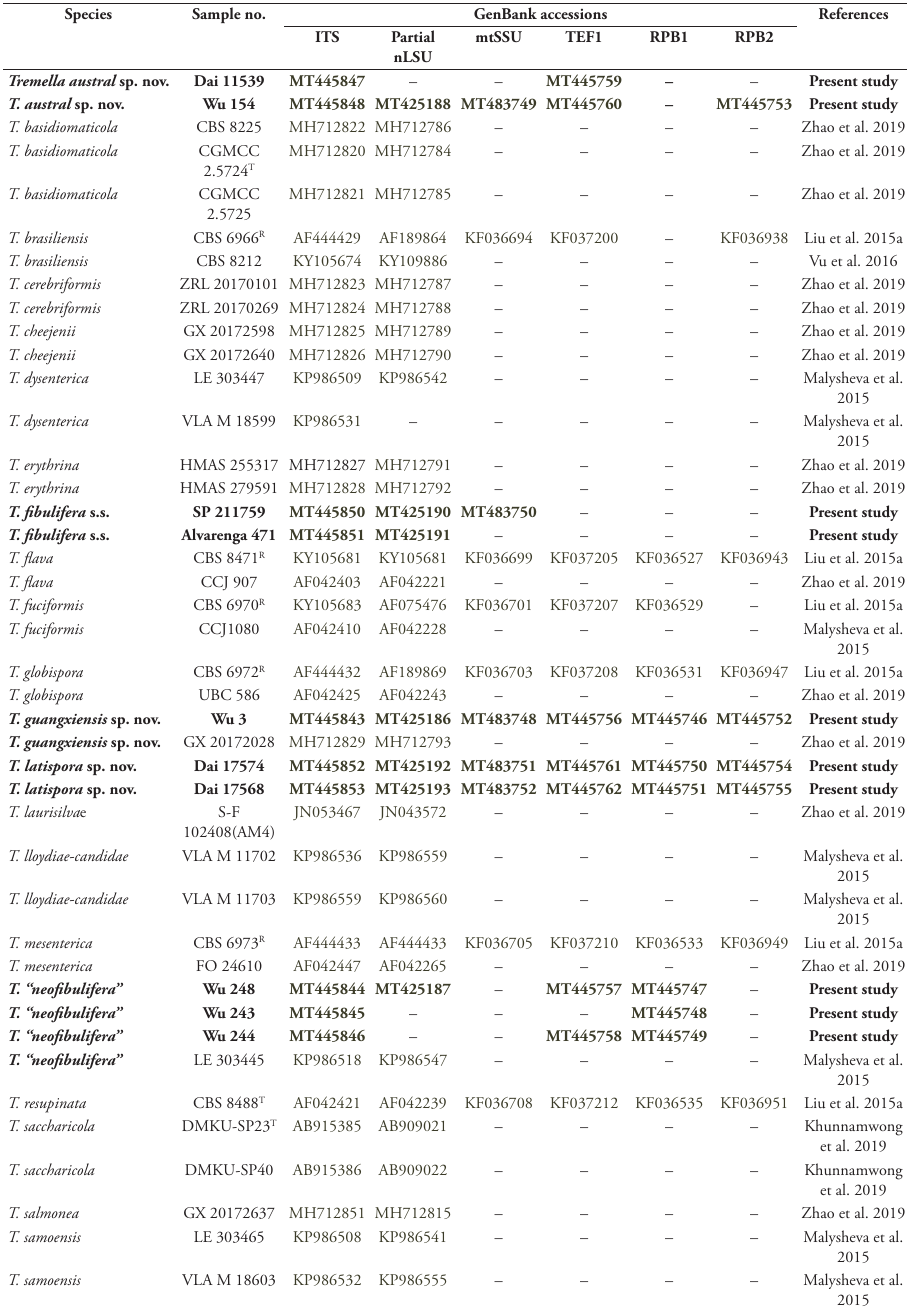
Table 2. Information on sequences used in this study. Species Sample